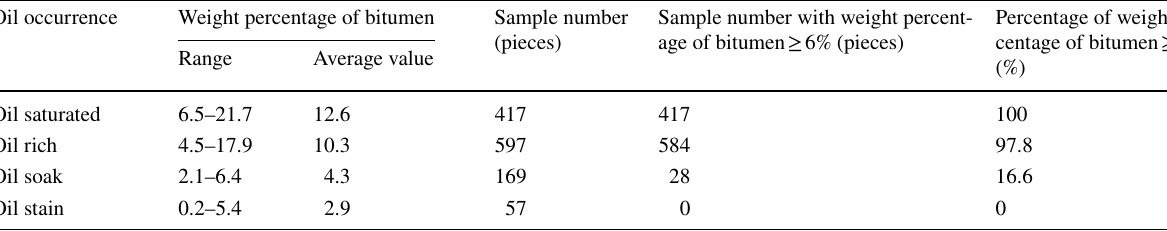
Table 1 Relationship between oil occurrence and weight percentage of bitumen in Fengcheng area Oil occurrence Weight percentage of bitumen